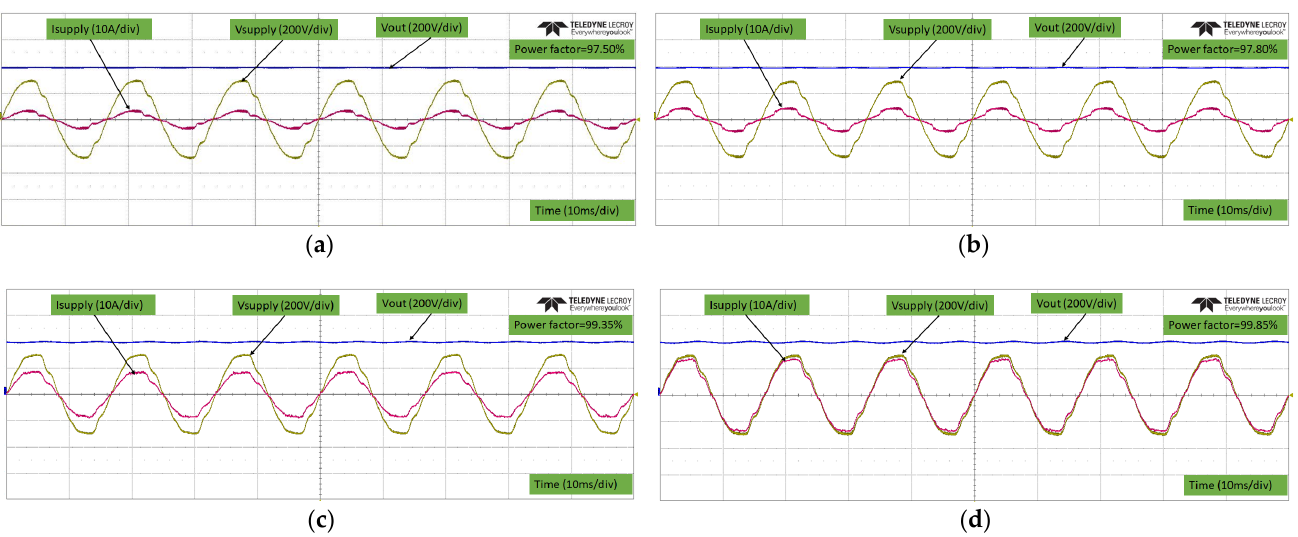
Figure 24. Input and output voltages, input current, and power factor of the designed conventional PFC converter with different loading condition. ( a ) 25%; ( b ) 50%; ( c ) 75%; ( d ) 100%.